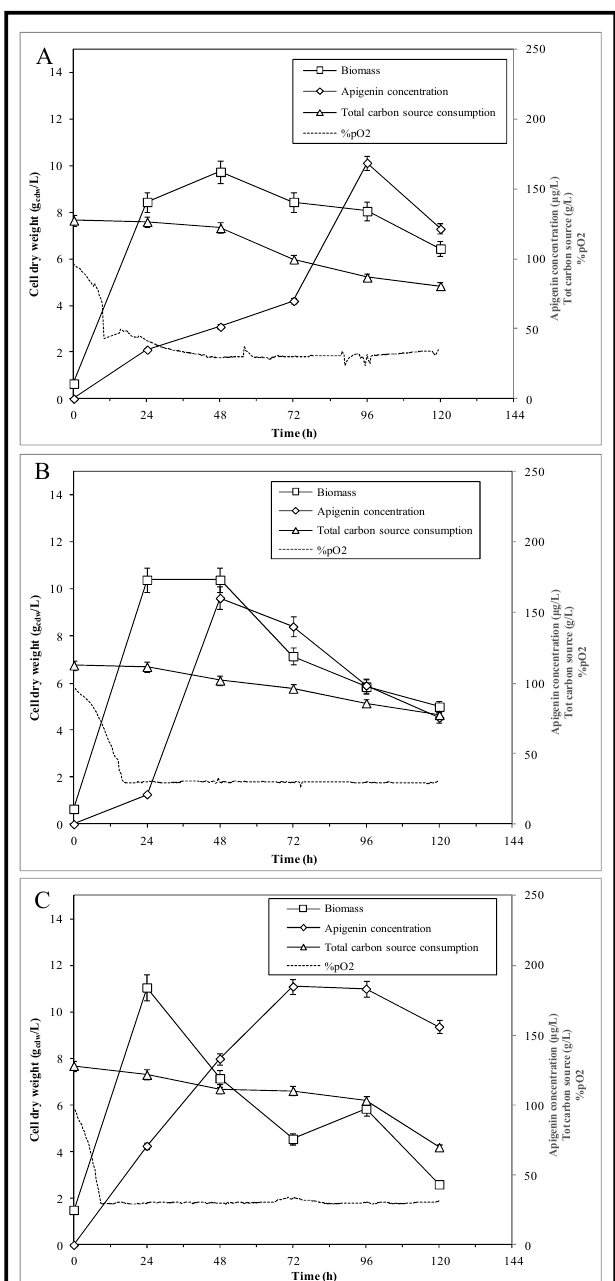
Figure 3. Bioreactor experiments of Streptomyces albus -pAPI performed by using two different stirring and aeration profiles—( A ) 300–800 rpm; 78–162 L·h − 1 and ( B ) 300–600 rpm; 102–120 L·h − 1 —and a double percentage of initial inoculum ( C ) (10% v / v ): kinetics of growth and apigenin concentration, total carbon source consumption and % pO 2 profile.